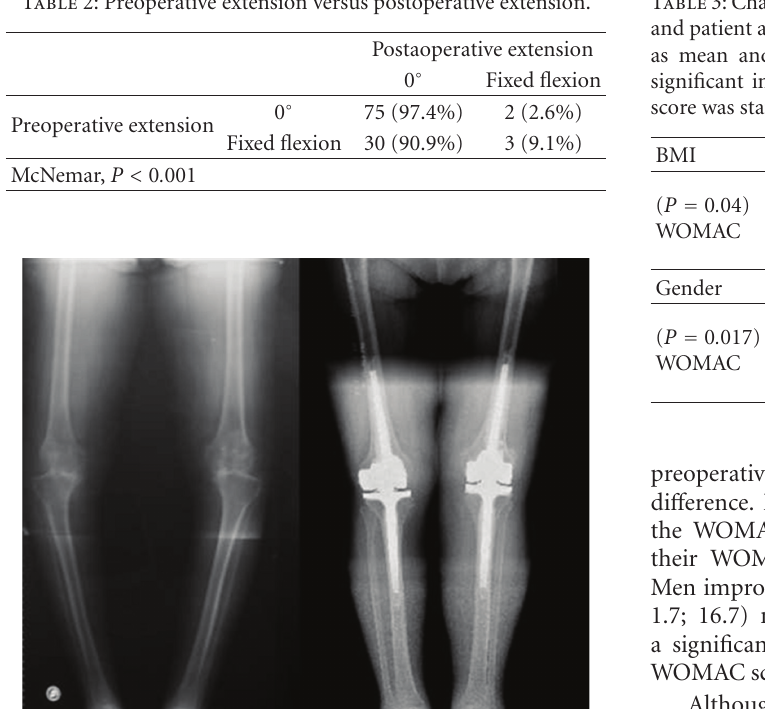
Men improved their WOMAC score by 9.2 points (95%